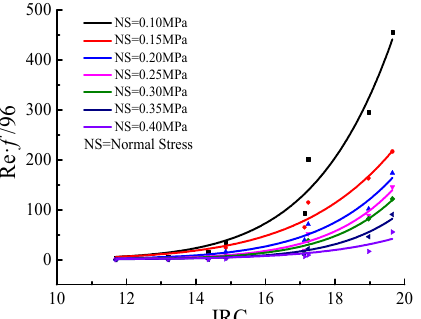
Figure 8. Relationship between JRC and Re · f /96 under different normal stresses.